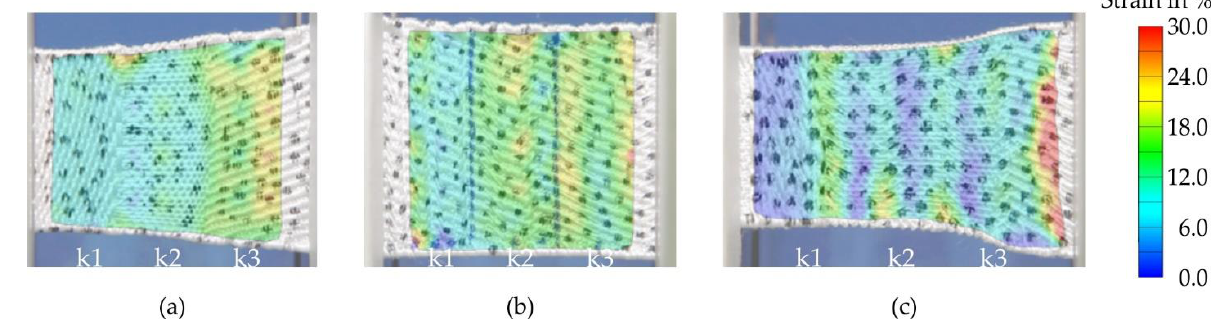
Figure 7. Exemplary images of DIC measurements during tensile testing of ( a ) GW1, ( b ) GW2, and ( c ) GW3.